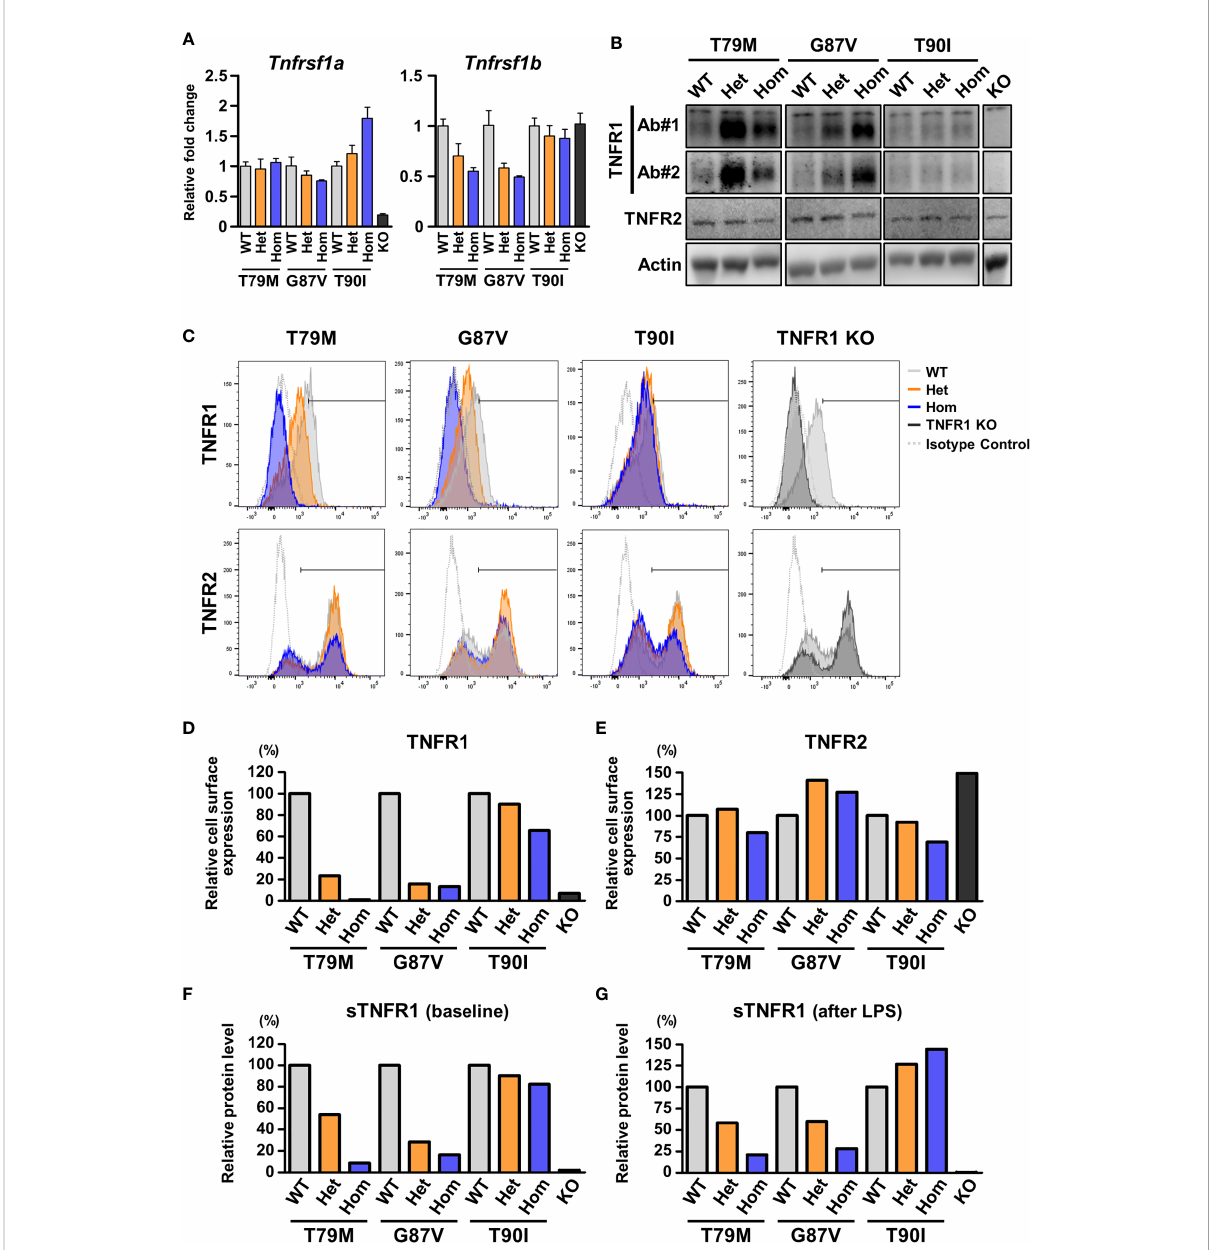
FIGURE 7 Decreased cell surface expression of TNFR1 in the TRAPS mutant cells. The expression of TNFR1 and TNFR2 were determined in primary murine bone marrow-derived macrophages and peritoneal macrophages. (A) mRNA expression levels of Tnfrsf1a and Tnfrsf1b in bone marrow-derived macrophages. (B) Immunoblot analysis of TNFR1 and TNFR2 expression in the bone marrow-derived macrophages. Two different antibodies against TNFR1 were used: Ab#1 (13377, Cell Signaling Technology) recognizes aa 29 – 43 (extracellular domain), and Ab#2 (AF-425-PB, R&D Systems) recognizes the C-terminal intracellular region. (C – E) Flow cytometric analysis of TNFR1 and TNFR2 expression. Peritoneal exudate cells were collected from the indicated mice 3 days after the intraperitoneal administration of thioglycolate. (C) Representative histograms of the cell surface expression of TNFR1 and TNFR2. The expression levels of TNFR1 (D) and TNFR2 (E) on the surface of CD11b-positive cells were determined by fl ow cytometry. The cells within the horizontal line on each histogram were recognized as TNFR1- or TNFR2-positive cells. The proportions of the positive cells were calculated relative to those of the WT in each strain. The following antibodies were used: TNFR1 (113005, BioLegend) and TNFR2 (113405, BioLegend). Both antibodies recognize the extracellular domains. (F, G) ELISA for soluble TNFR1 (sTNFR1) in the culture supernatant of bone marrow-derived macrophages. Culture supernatant was collected before (F) and 24 h after (G) LPS stimulation. Concentrations of sTNFR1 in the culture supernatant were measured by ELISA, and the levels were calculated relative to that of the WT in each strain. TRAPS, TNF receptor-associated periodic syndrome; LPS, lipopolysaccharide; ELISA, enzyme-linked immunosorbent assay; WT, wild-type; Het, heterozygote; Hom,